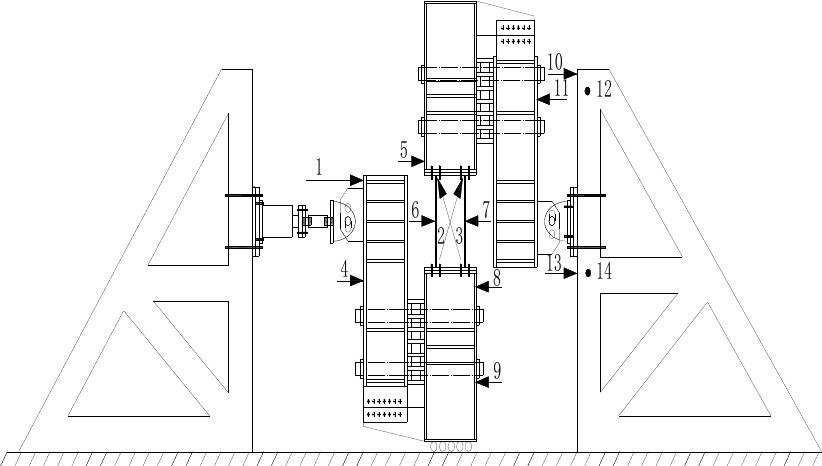
Figure 5. The measurement arrangement of displacements.